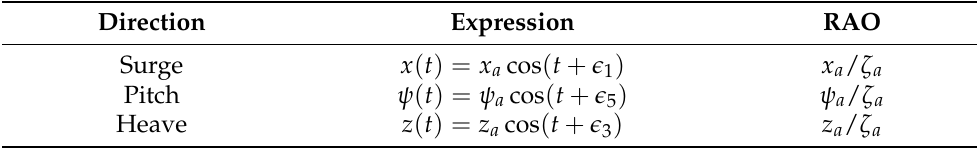
Table 4. The RAOs resulting from the